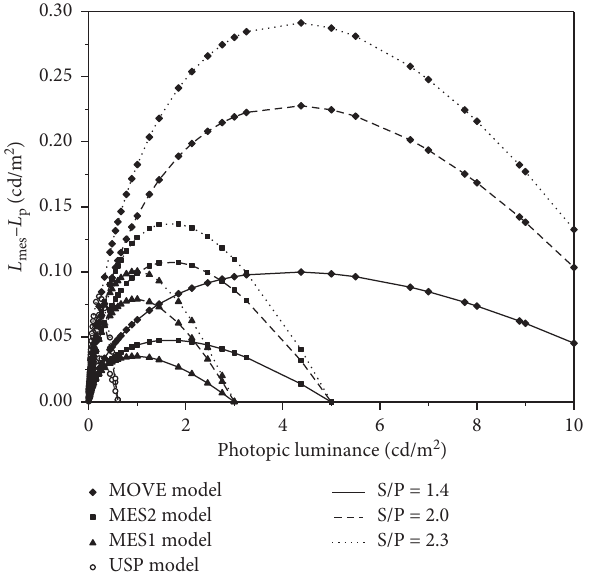
Figure 6: Comparison of four mesopic photometry models with different S/P